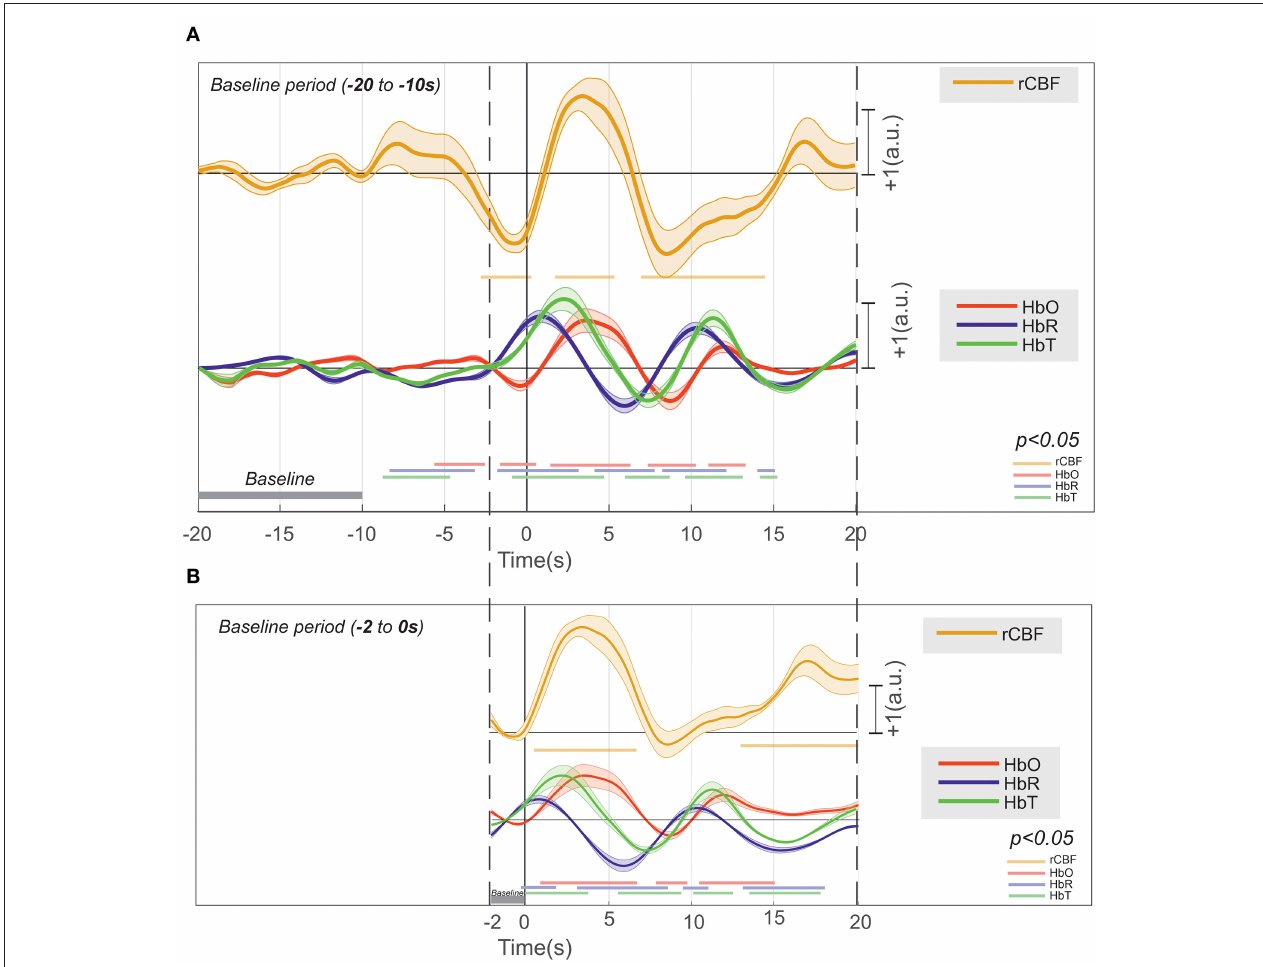
FIGURE 10 | Deconvolution of the hemodynamic response of [HbR], [HbO 2 ], [HbT], and rCBF that occurs around an IIS ( n = 17,995), with their significance ( p < 0.01) drawn at the bottom in their respective colors. (A) The baseline at − 20 to − 10s and (B) the baseline at − 2 to